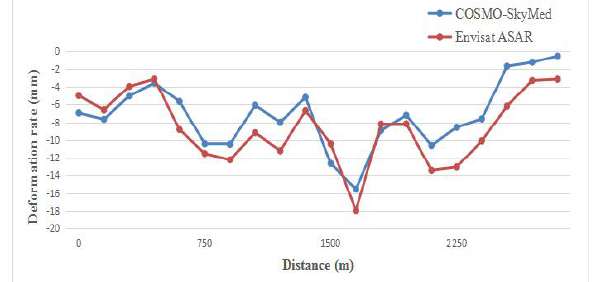
Figure 8. The displacement rate in the vertical direction of the experiment area(from Gaoke West Road Station to Gaoqing Station )